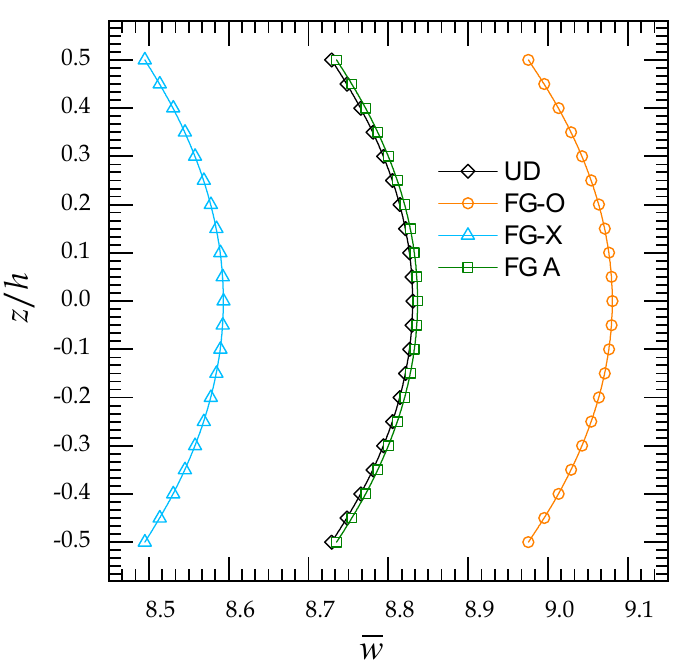
(cid:0) = 1% (cid:1) . g ∗ GPL